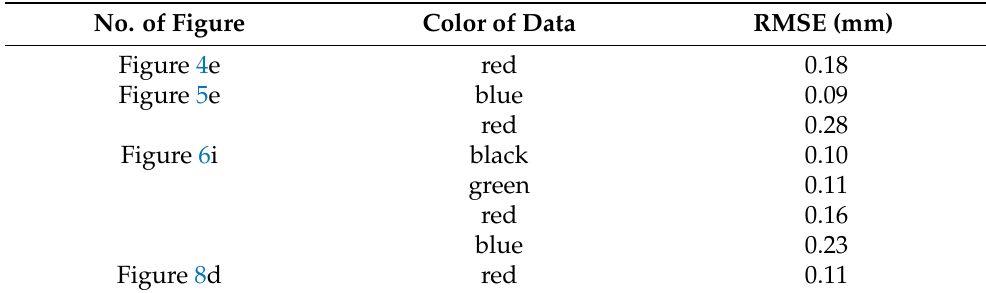
Table 1. Comparison of RMSE of different